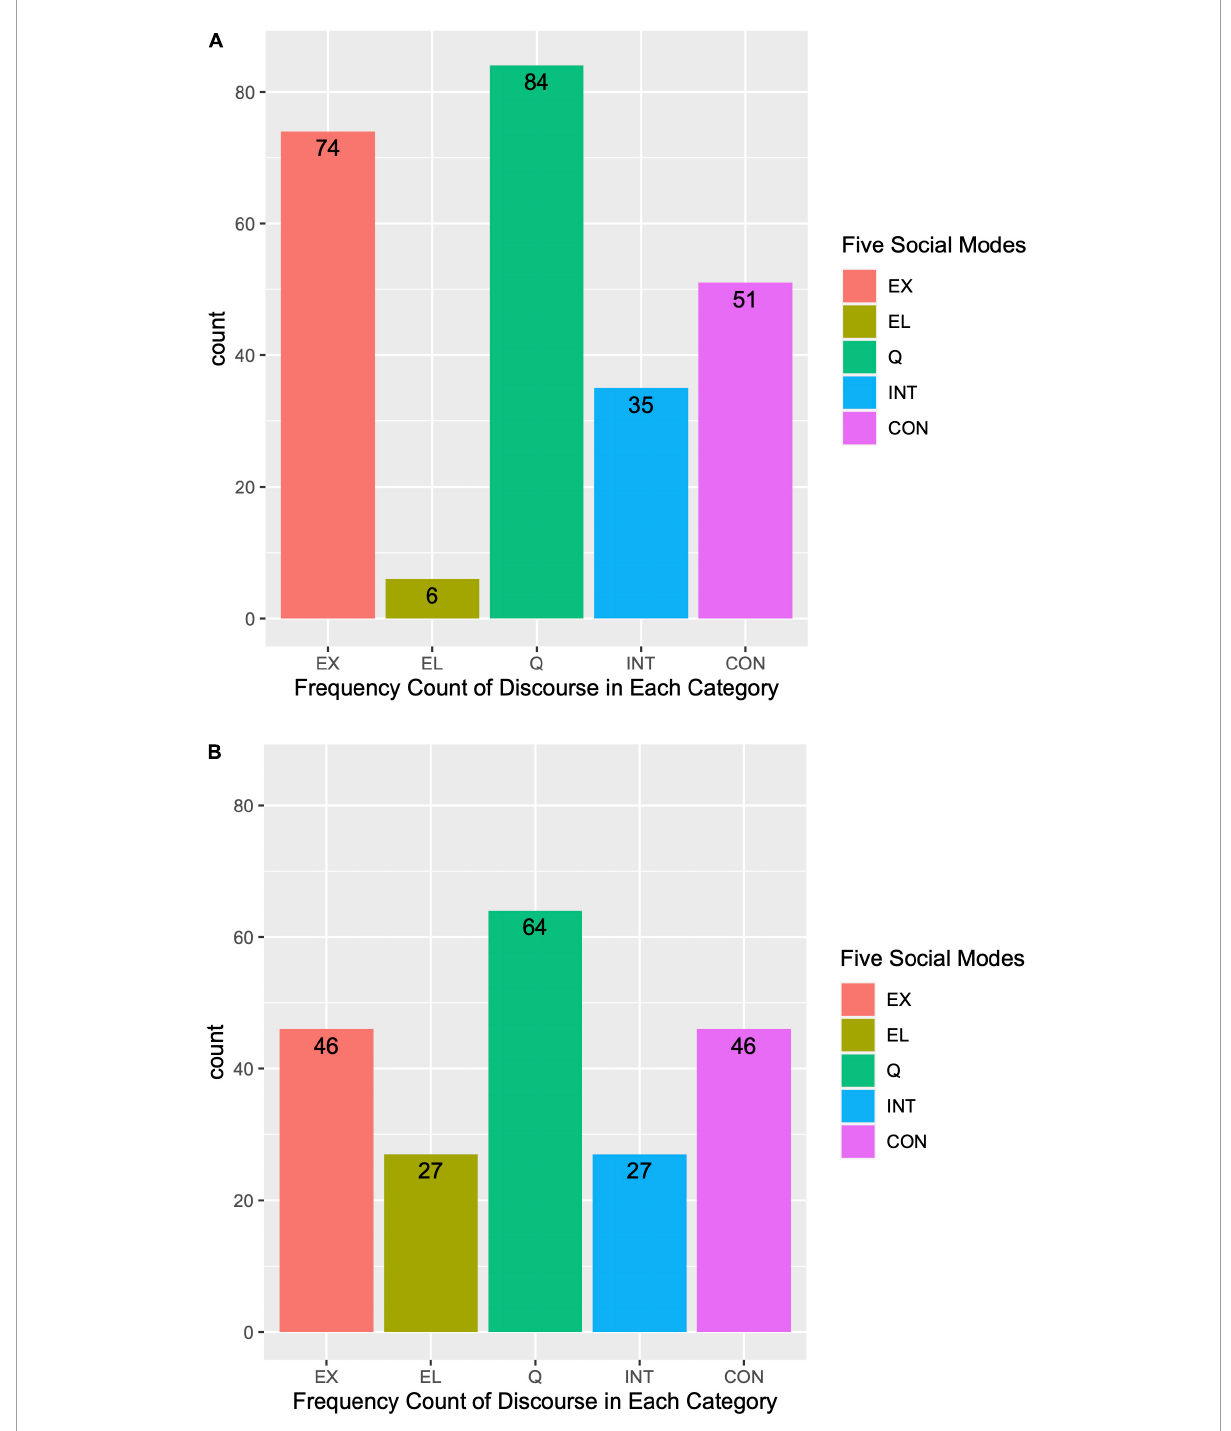
FIGURE5 Histograms of different categories of different social modes from control dyad (A) and experimental dyad (B) ’s discourse.